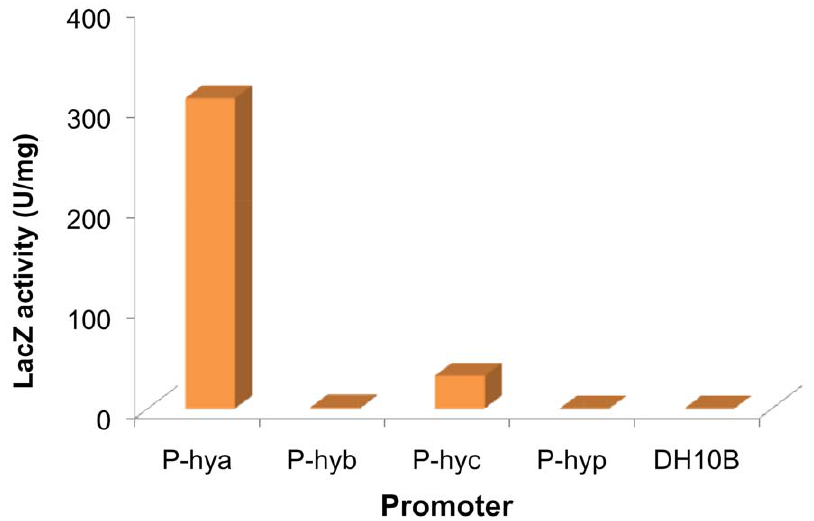
Figure 2. Analysis of E.coli promoters with a lacZ gene fragment b -galactosidase reporter assay. Plasmids were transformed into DH10B. The specific activity of lacZ was measured by a modified Miller [30] assay calculated as 200(OD 420-t1 -OD 420-t2 ) min 2 1 mg 2 1 , where t1 and t2 are the start and end time points, respectively.